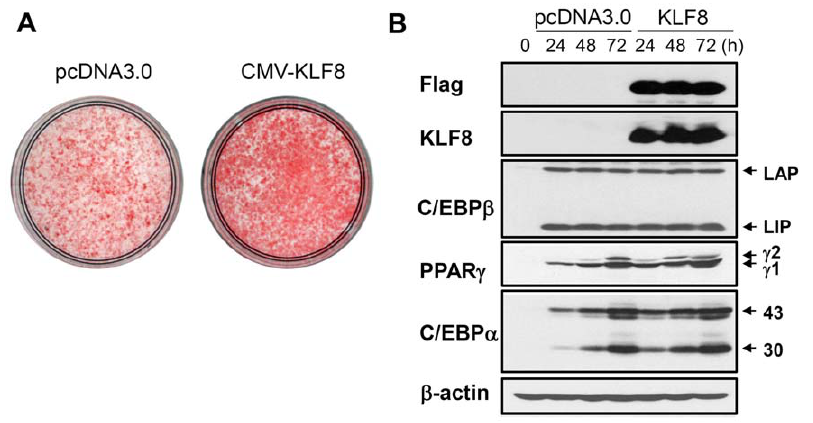
Figure 3. Overexpression of KLF8 results in enhanced differentiation. Preadipocyte 3T3-L1 cells were transiently transfected using electroporation with pcDNA3.0-KLF8-FLAG or empty vector and differentiated with standard hormonal cocktail as described in Materials and Methods. (A) After 5 days of differentiation, lipid accumulation was detected by oil red-O staining. (B) Western blot analysis of whole-cell extracts prepared at the indicated times during differentiation. LAP, liver-activating protein, LIP, liver-inhibitory protein, PPAR c 1, PPAR c 2, and 43 or 30 kDa of C/EBP a proteins were indicated.